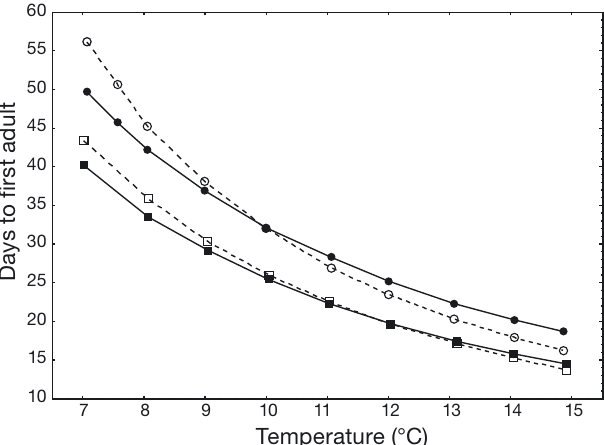
Fig. 6. Comparison of the predictions made by the Stien et al. (2005) model (dashed line) vs. the present model (solid line) for male ( h ) and female ( s ) Lepeophtheirus